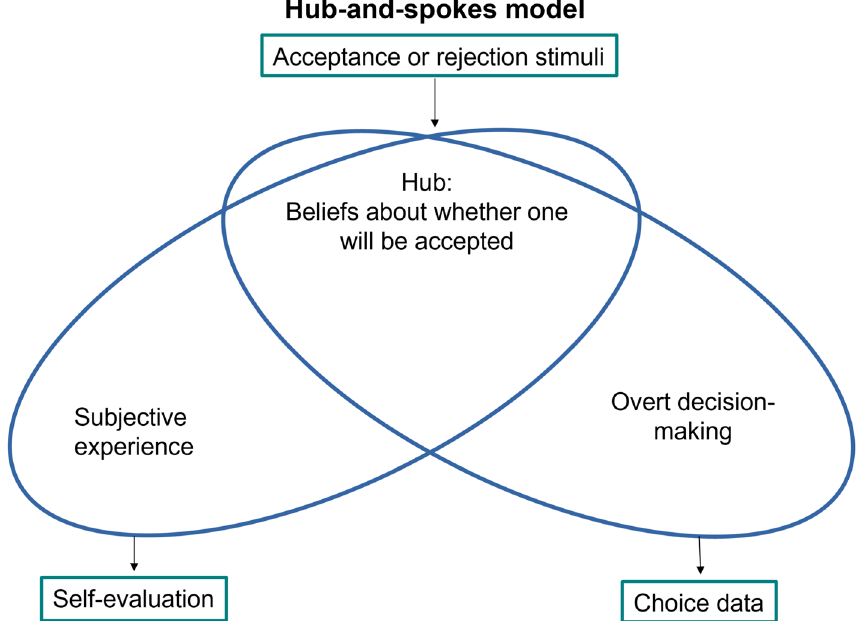
Figure 2. All models contained a ‘hub’ that learnt about approval by others, and so held expectations about whether one will be approved or not. The ‘hub’ contained probabilistic beliefs as illustrated or, in the case of associative models, approval values. Approval or disapproval stimuli then gave rise to (social) prediction errors (SPEs). Expectations and SPEs were passed on to ‘spoke’, or response processes: self-esteem (scale data) and approval predictions (choice data).